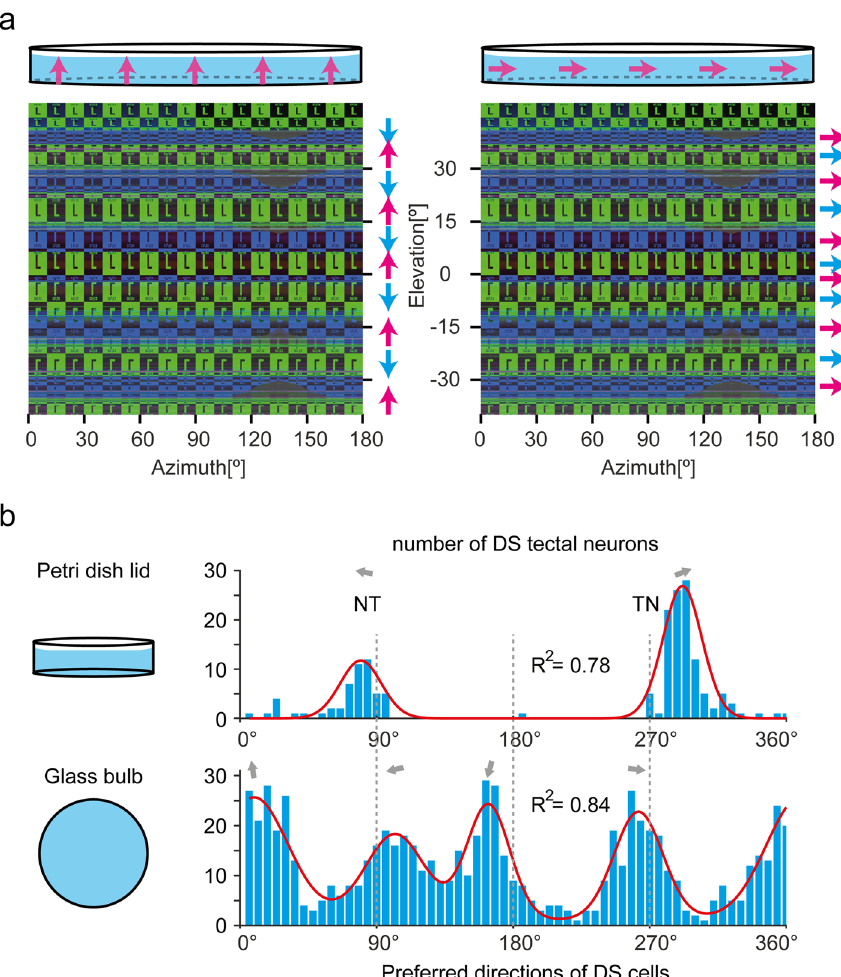
in elevation) are intermingled and oftentimes oriented upside-down (background colors and letters ‘L’, also see Fig. 1f). Left side: vertical upward motion (indicated by magenta arrows) is presented from outside of a Petri dish. The whole moving pattern is disrupted and not continuous from the perspective of the animal in the center of the container. At different elevation levels of the visual field, the stimulus patches move upwards (magenta arrows) or in the opposite direction (cyan arrows). Right side: horizontal motion (indicated with magenta arrows) to the right is presented from outside of a Petri dish lid. Seen from the center of the Petri dish, the whole moving pattern is still continuous, consistent and homogeneous (cyan and magenta arrows). ( b ) Histograms of the preferred directions of direction-selective tectal neurons recorded in a Petri dish lid (top, n = 5 fish) or a glass bulb (bottom, n = 9 fish). The peaks were fitted with a sum of two (top) or four (bottom) Von-Mises functions (red lines). The PDs are indicated with gray